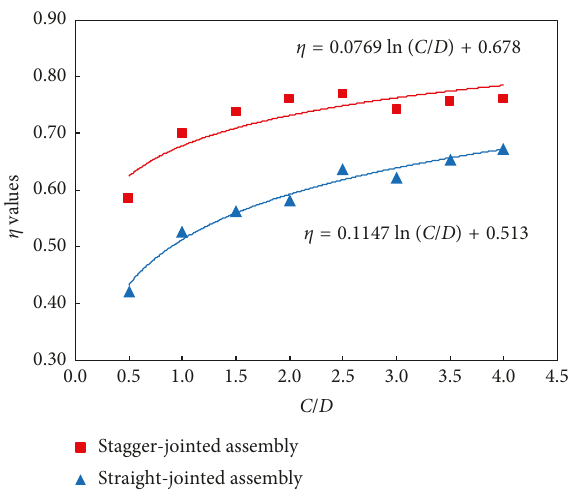
Figure 17: Logarithmic curves between the η values and the loads based on the realistic loading pattern. Table 4: Values of η calculated based on the formulas proposed in this